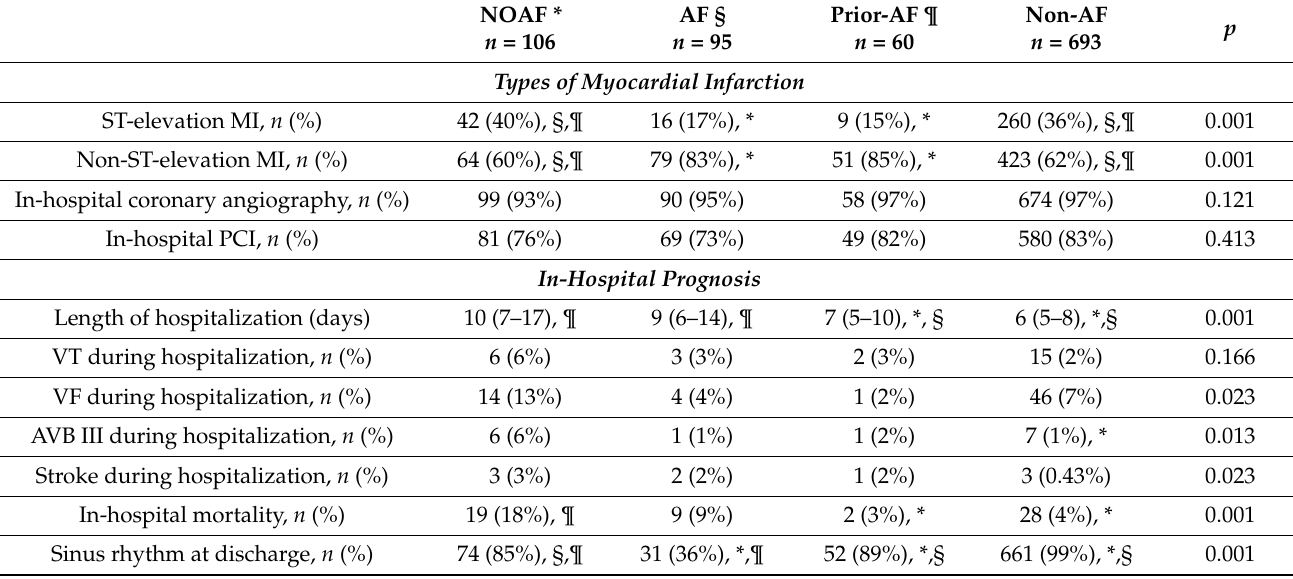
Table 2. Types of AMI, results of coronary angiography, and in-hospital prognosis.